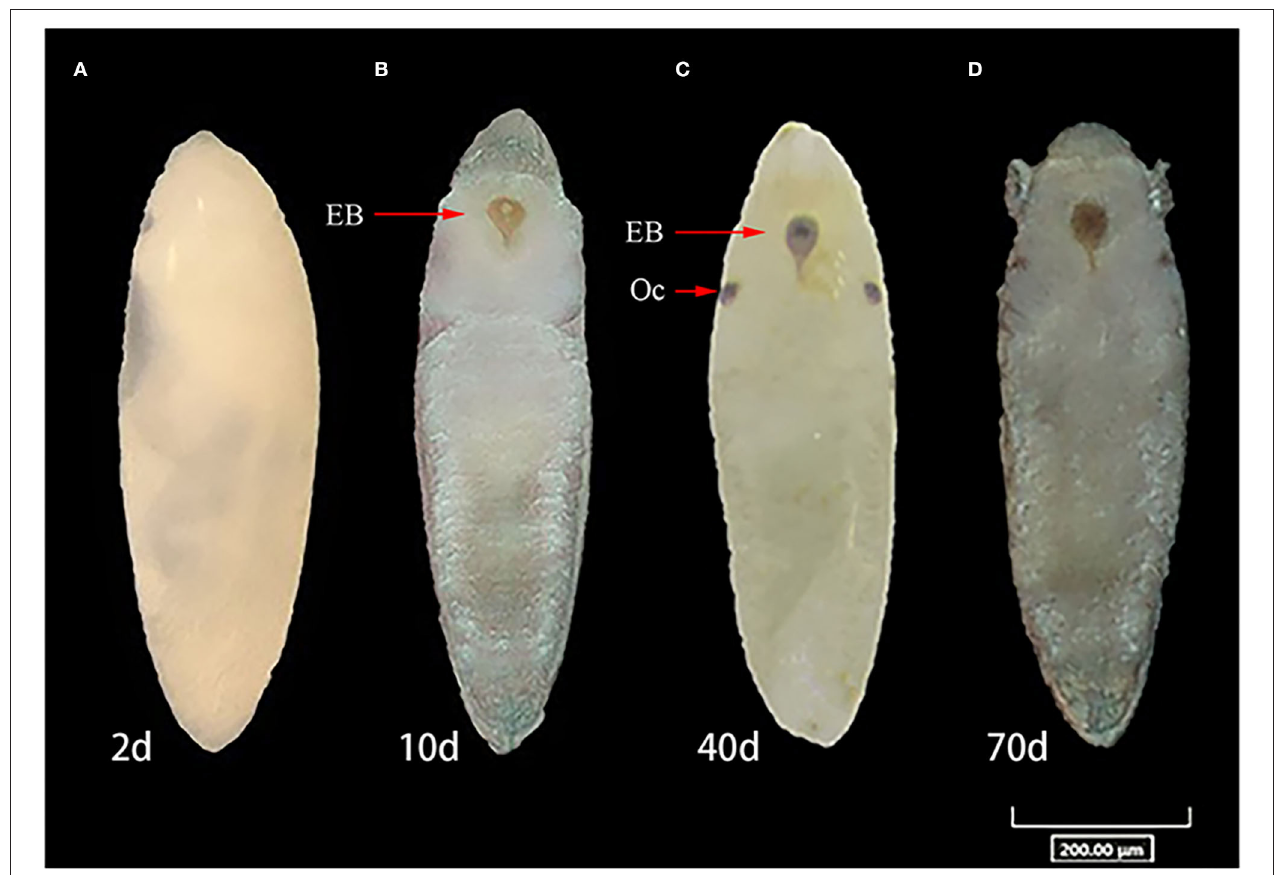
FIGURE 5 | Comparison of developmental stages of diapause, non-diapause eggs of Ae. albopictus under short-day photoperiod. (A) Egg in embryonic development on 2 days post-oviposition (dpov). (B) Ventral view of embryo with appearance of the head with labrum, thorax, abdominal segments, and associated structure on 10 dpov. (C) View of diapause embryo with ocelli and egg burster on 40 dpov. (D) Diapause eggs on 70 dpov. OC represents ocelli. EB, egg burster.